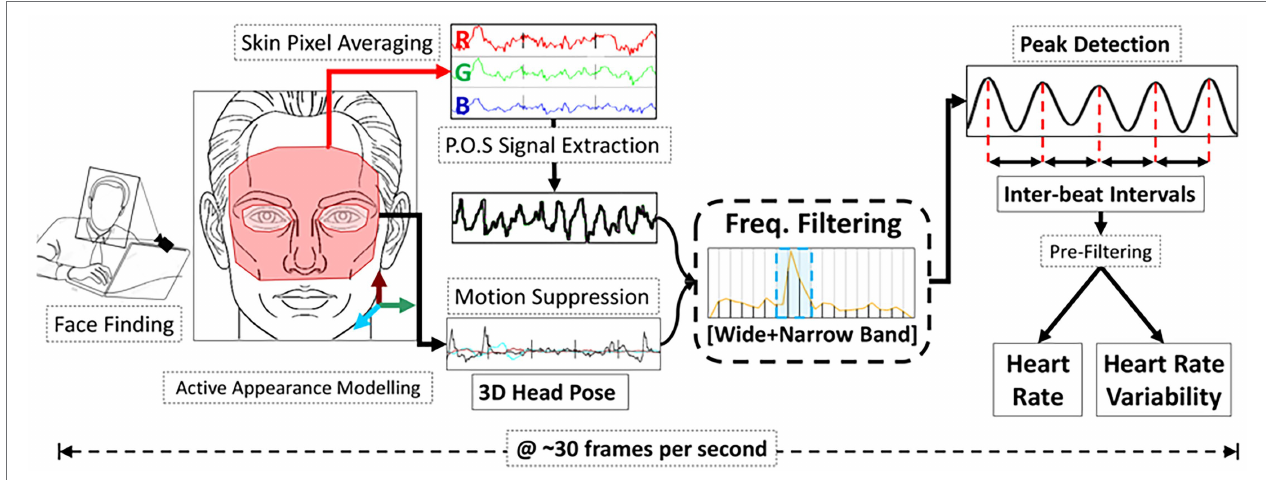
FIGURE 4 | An example of the pipeline used to extract HR and heart rate variability from rPPG signal extracted through a color-based method based on POS post- processing algorithm (from Gudi et al.